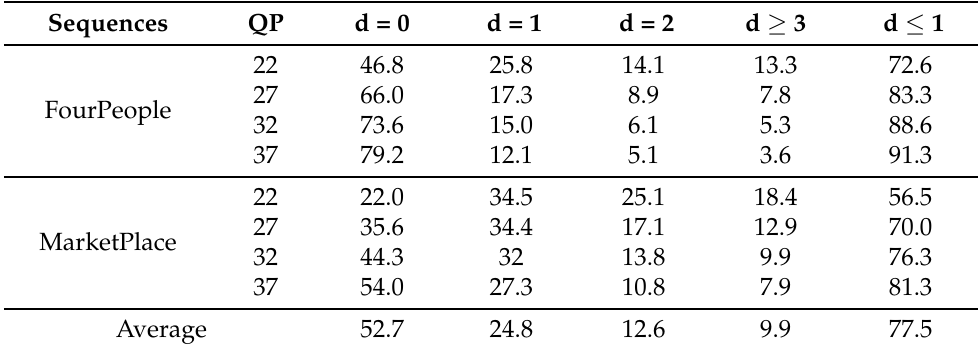
Table 3. The distribution of the QTMT depth difference between adjacent frames (unit: %).